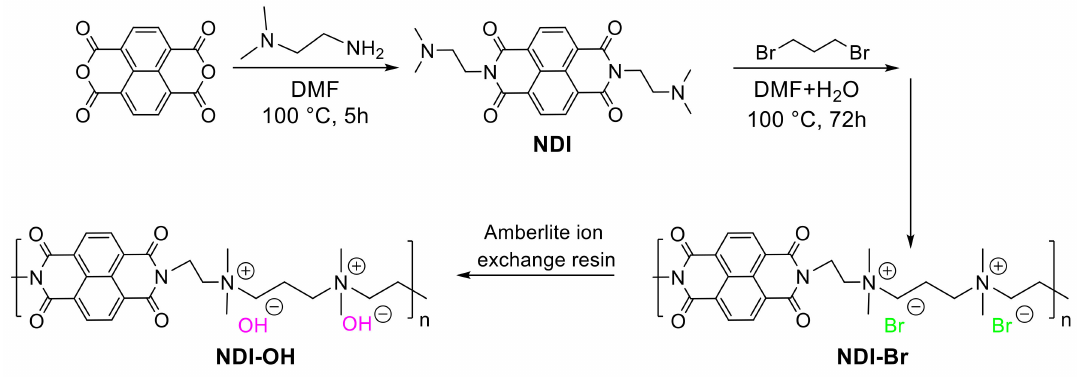
Figure 1. Three-step synthesis of naphthalene diimide-based cathode interlayer (NDI-OH). Synthesis of NDI. N, N-dimethylethylenediamine (2.5 mL, 22.5 mmol) was